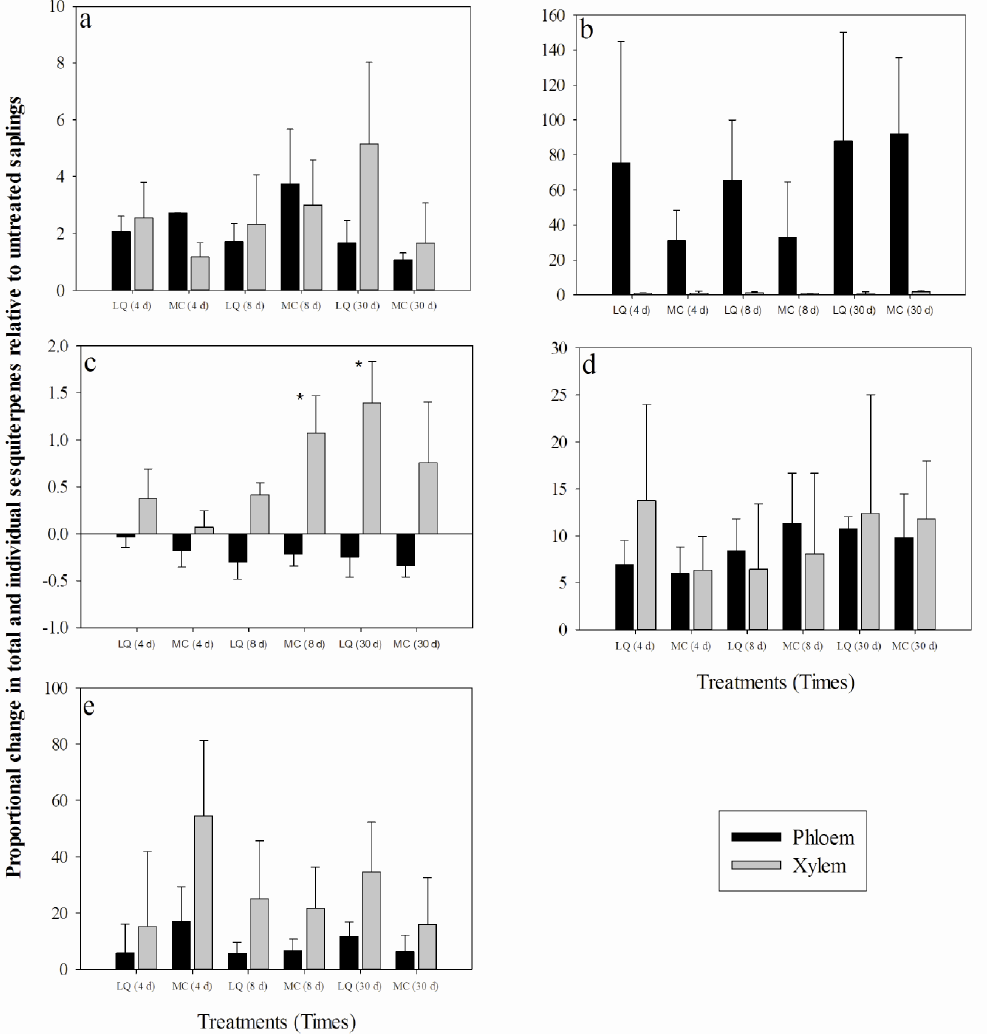
Figure 5. The change in total and individual sesquiterpenes between the phloem and xylem of the stem in the same treated saplings relative to the corresponding total and individual monoterpenes in the untreated saplings at all time points after treatment. LG = L. qinlingensis -inoculated saplings; MC = Mechanically wounded saplings; a = total sesquiterpene concentrations; b = longifolene; c = germacrene; d = α -muurolene; e = δ -cadinene; * indicates that there was a significant difference ( p < 0.05) between the phloem and xylem of the stem in the same treated saplings based on a Student t -test at the various time points; Each bar represents the mean total ± standard error of three